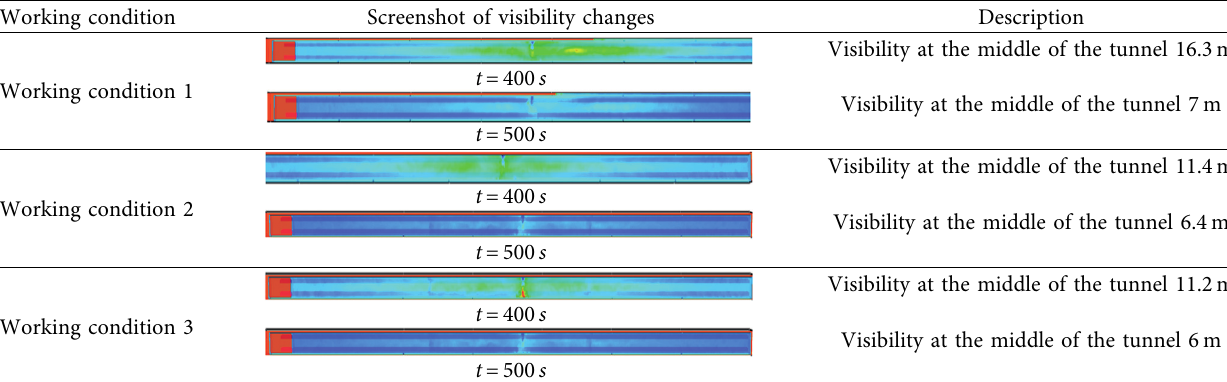
Table 9: Comparison of visibility changes under working conditions 1, 2, and 3.